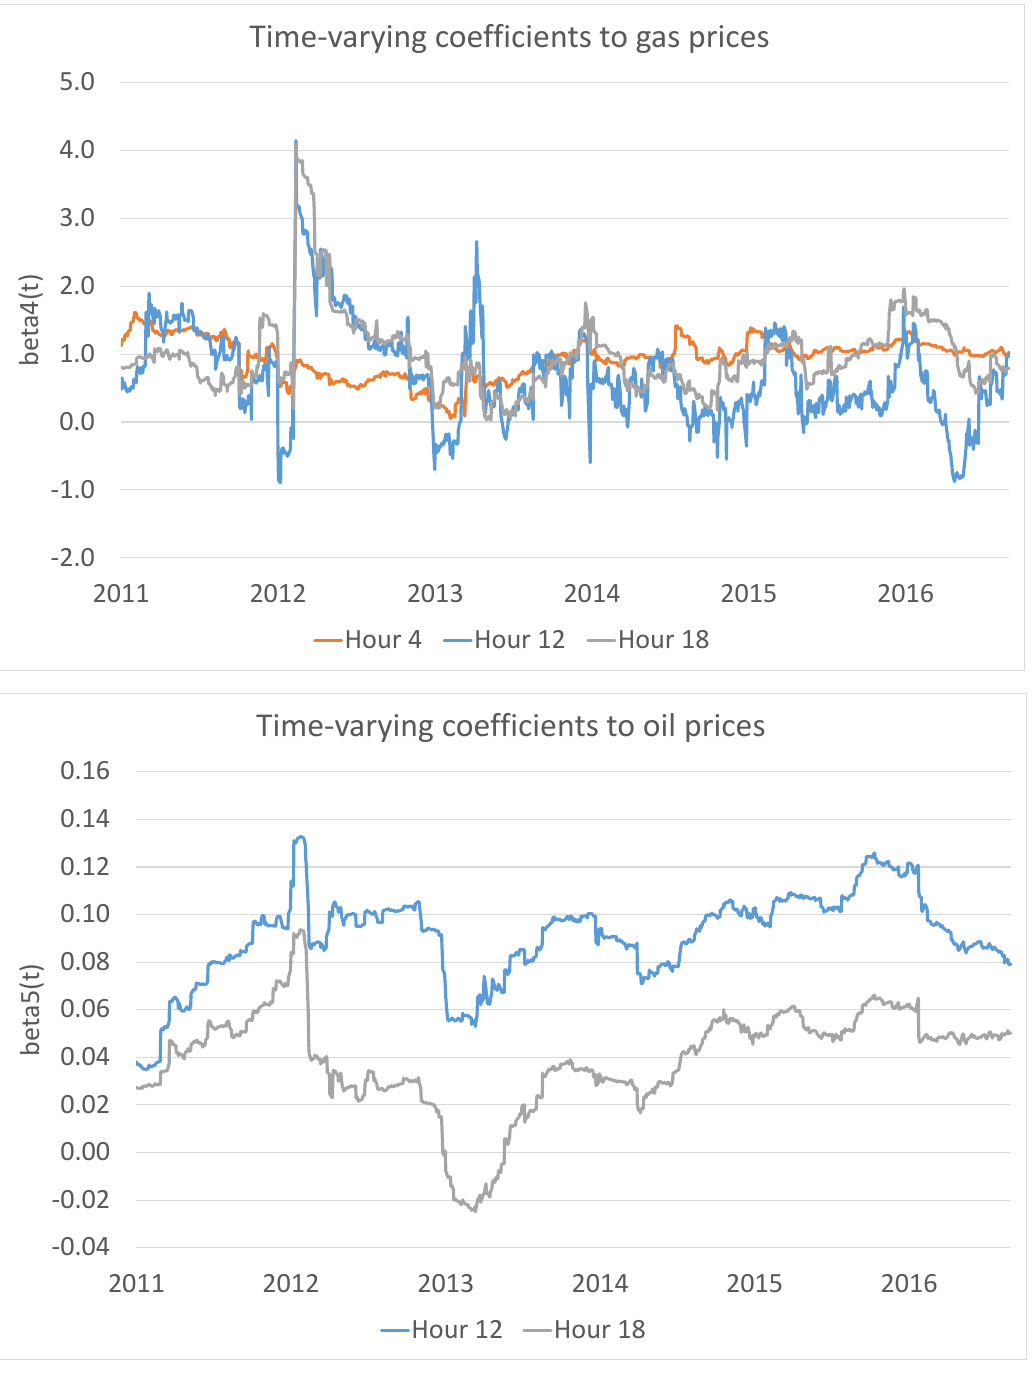
Figure 7. Time-varying coefficients of gas and oil prices. The coefficients have been estimated for the sample period from 1 January 2011 until 31 August 2016 with respect to the key hours H4, H12 and H18 on working